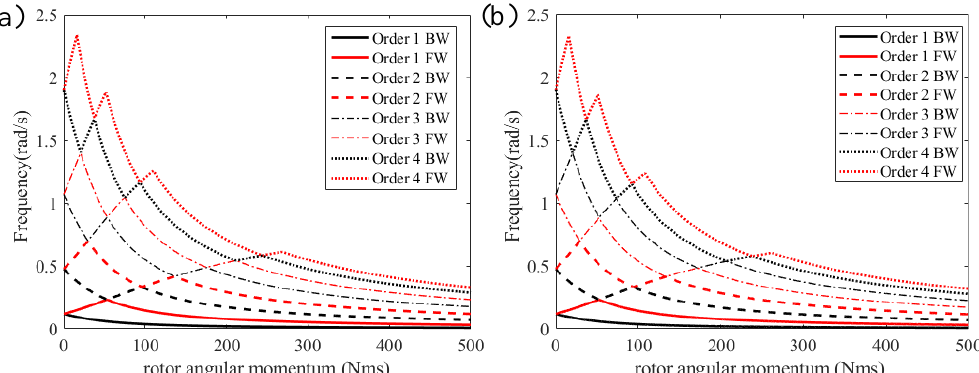
Figure 4. The varying natural frequencies with increasing angular momentum. ( a ) The results of the modal discretization. ( b ) The results of the spatial discretization.